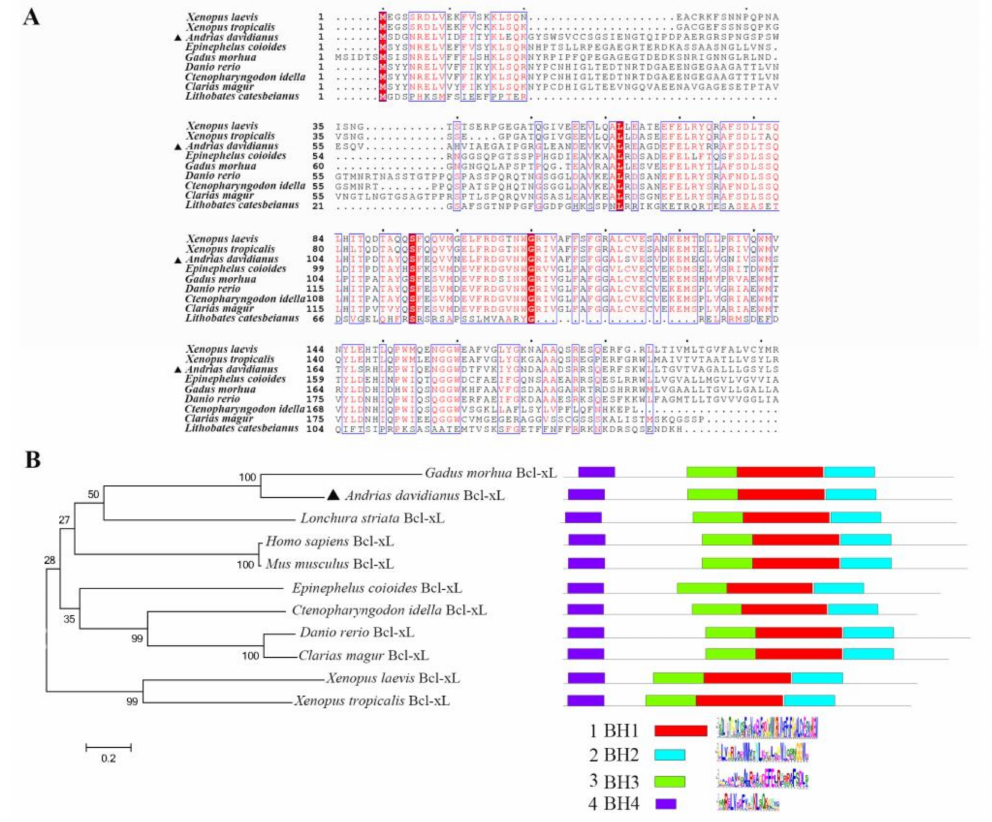
Figure 1. Sequence analysis of AdBcl-xL. ( A ) Alignment of the amino acid sequences of AdBcl-xL homologs in amphibians and fish. Dots denote gaps introduced for maximum matching. Numbers in brackets indicate overall sequence identities between AdBcl-xL and the compared sequences. The consensus residues are shaded in red, and residues that are ≥ 75% identical are identified as red characters. AdBcl-xL is marked by a triangle. ( B ) Neighbor-joining phylogenetic tree and conserved motifs of AdBcl-xL homologs from different vertebrate species. AdBcl-xL is marked by triangles. Numbers beside the internal branches indicate bootstrap values based on 1000 replications. The 0.2 scale indicates the genetic distance. Red boxes indicate BH1 domains; Blue boxes indicate BH2 domains; Green boxes indicate BH3 domains; Purple boxes indicate BH4